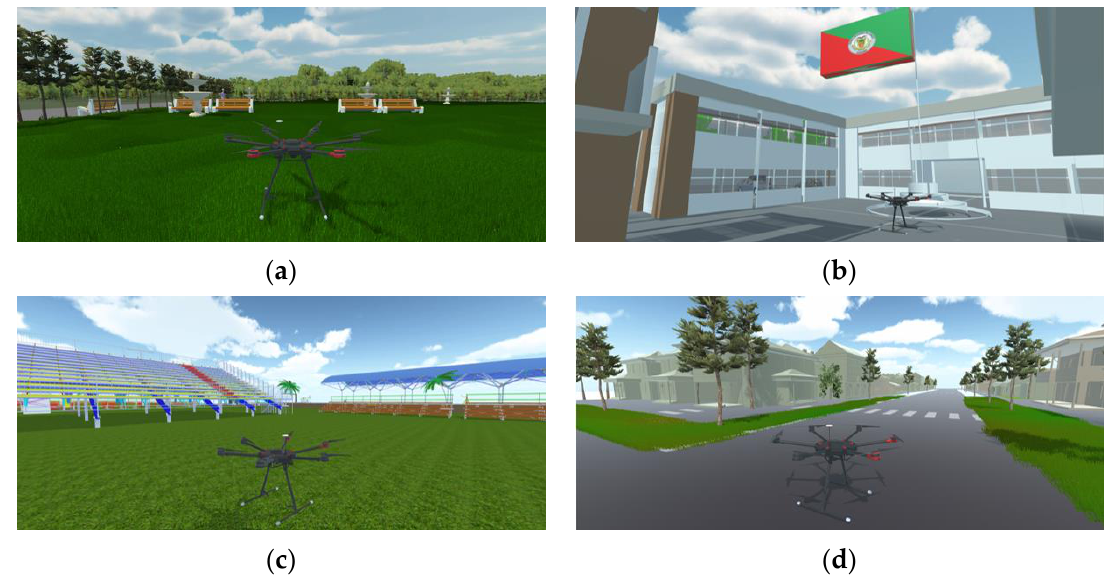
Figure 8. Virtual scenarios developed for the execution of trajectory tracking tasks, all related to real life. ( a ) Park Scenario; ( b ) Educational Center Scenario; ( c ) Stadium Scenario; ( d ) Neighborhood Scenario.